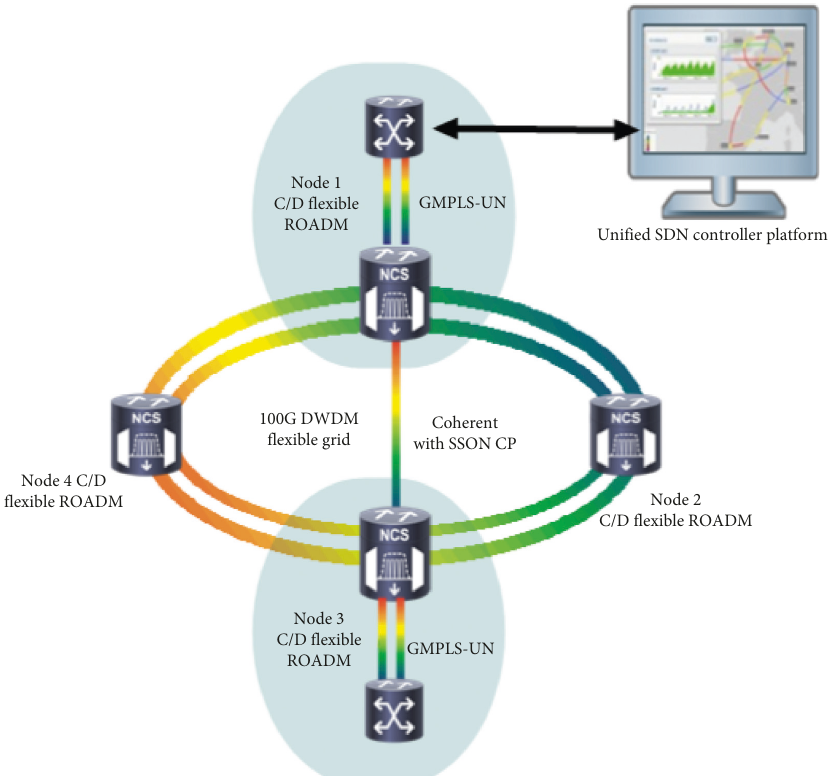
Figure 1: Simple topology of the multinode network used for the experimental demonstration of bandwidth utilization for the flexible bandwidth network